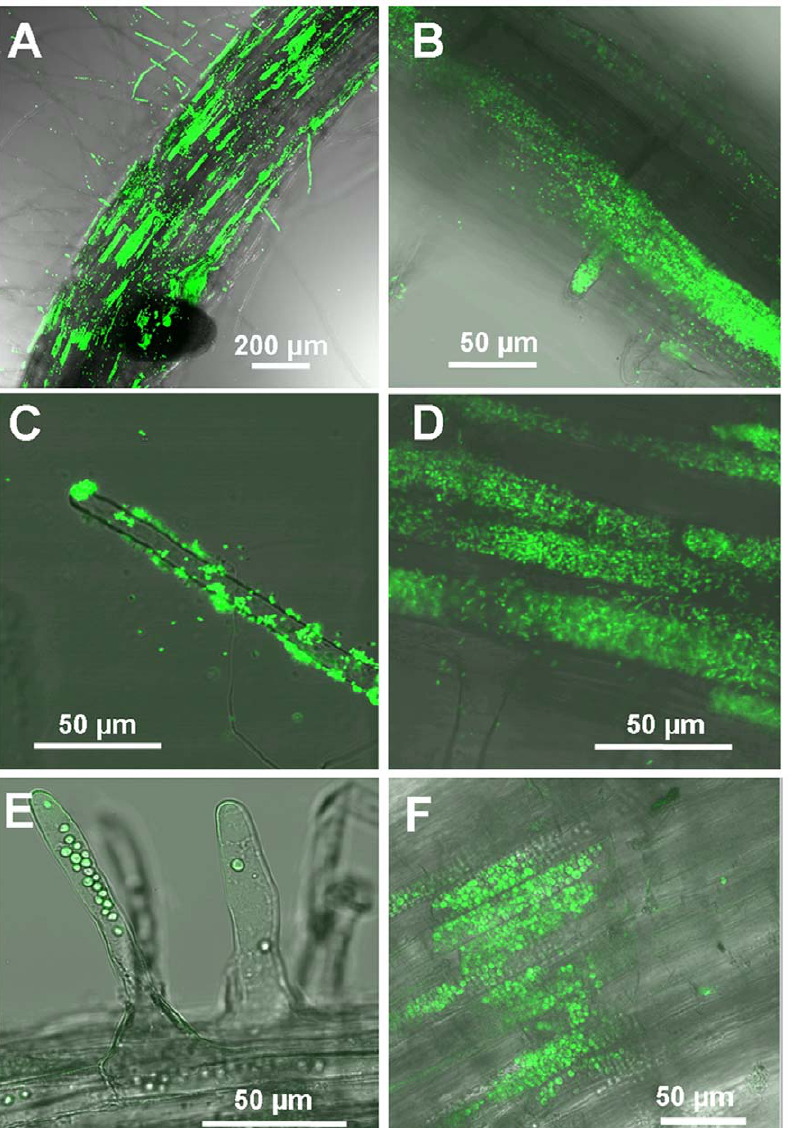
Figure 1. Roots of axenically grown Arabidopsis and tomato were incubated with Ecoli or yeast expressing green fluorescent protein ( GFP E.coli or GFP yeast). GFP E. coli was detected at the surface of roots and root hairs (A and C), and inside roots and root hairs (B and D). GFP Yeast was present inside roots and root hairs (E and F). (A, D and F) and (B, C and E) correspond to tomato and Arabidopsis root, respectively. Fluorescent images were taken by confocal laser scanning microscopy (CLSM).